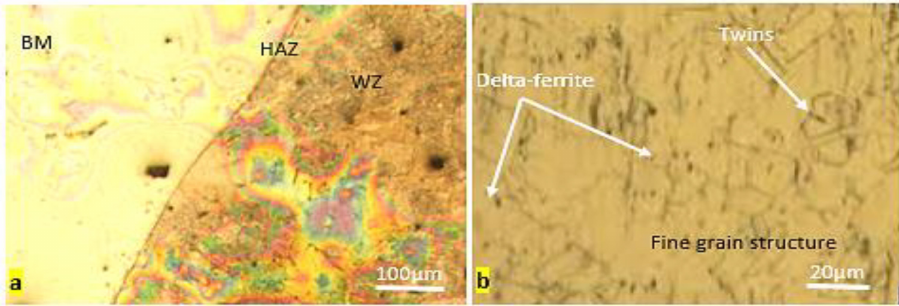
Figure 14. Microstructure of welded joint made of SS316 and AISI 1020 (sample 10): ( a ) welded joint; ( b ) weld metal.